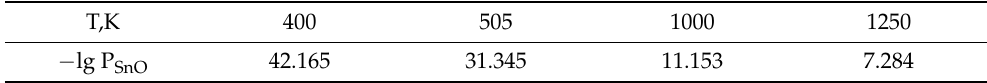
Table 1. Temperature dependency lg P SnO =